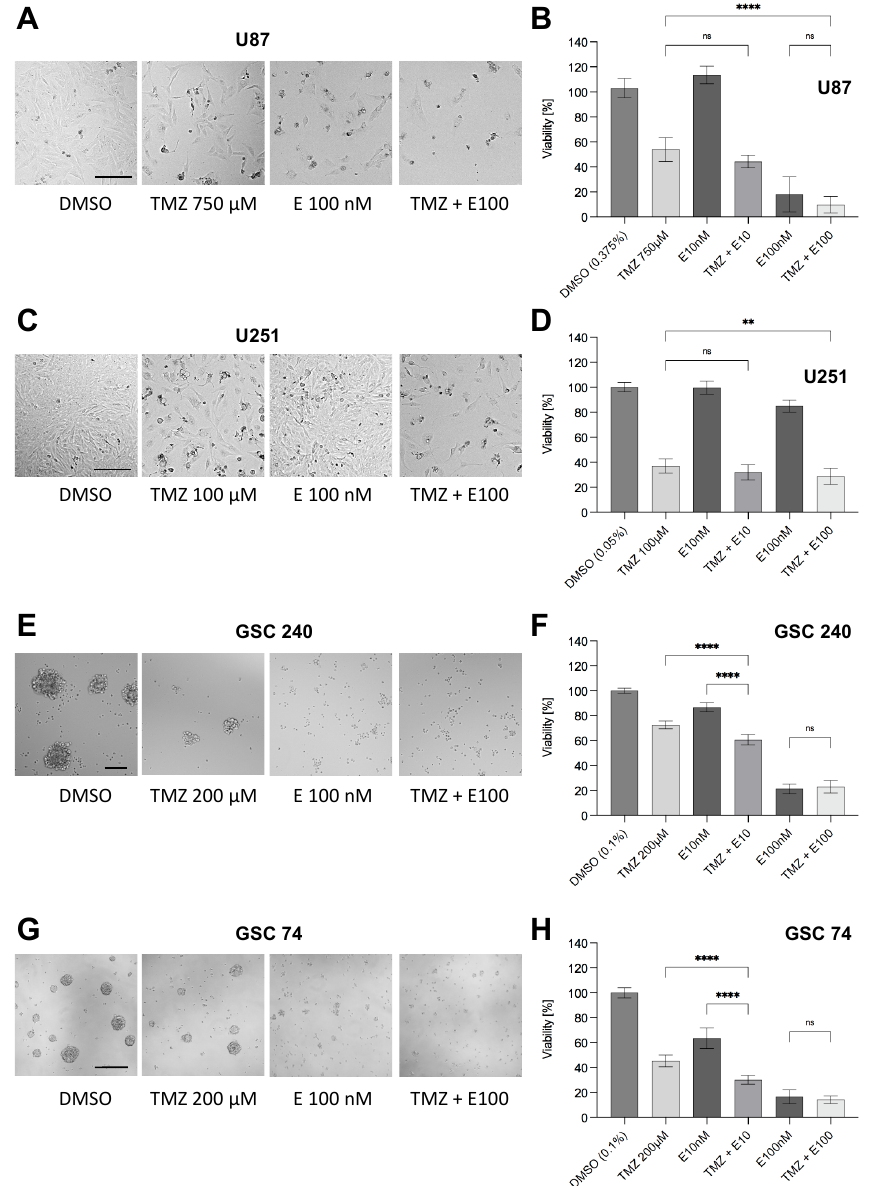
Figure 5. Effect of co-treatment TMZ/Eltanexor (10 and 100 nM) and temozolomide IC 50 concentrations determined for each cell line (750 µ M for U87, 100 µ M for U251, and 200 µ M for GSC cells, respectively) on viability of GBM cell lines U87 and U251 and GSC cells (2016/240 and 2017/74) after 5 days for cell lines and 10 days for GSC cells. Left panel ( A , C , E , G ), representative bright-field micrographs demonstrating cell loss after treatment. Right panel ( B , D , F , H ), quantification of cell viability using CellTiter-Glo ® . All viabilities are shown relative to DMSO as solvent corresponding to the TMZ + 100 nM Eltanexor condition. Values are provided as a result of three independent experiments performed in triplicates. Statistical significance was determined using one-way ANOVA with **, p < 0.01, and ****, p < 0.0001. Scale bars in ( A ), valid for all images, 200 µm.